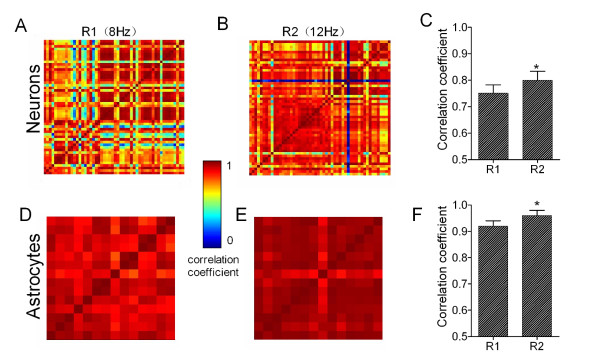
The activity synchrony of neuronal and astrocytic networks increases in responses to whisker stimuli with high frequency. A ~ B) Correlation matrices show cross-correlations for each of neuron-pairs in response (Ca2+ signals) to paired burst-stimuli, including response one (R1) vs. response two (R2) to 8 Hz (A) and 12 Hz (B) of stimulus frequency, respectively. C) shows a comparison of correlation coefficients averaged from all active neuron-pairs (excluding auto-correlations) in responses to paired burst-stimuli at 8-to-12 Hz. D ~ E) Correlation matrices show the cross-correlations for each of astrocyte-pairs in response to paired-stimuli, including R1 vs. R2 to 8 Hz (A) and 12 Hz (B) of stimulus frequencies, respectively. F) shows a comparison of the correlation coefficients averaged from all active astrocyte-pairs in responses to paired burst-stimuli (8-to-12 Hz). Asterisk presents p < 0.05 in paired student’s t-test.